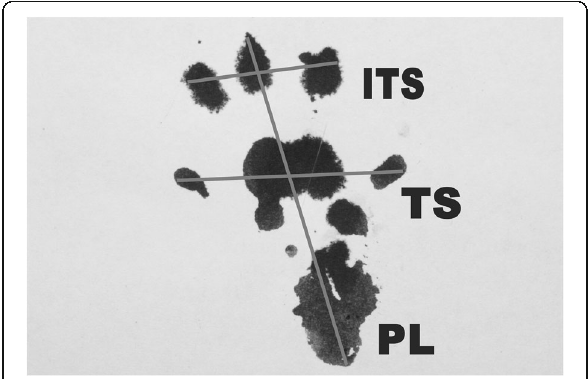
Fig. 2 Normal footprint after walking track analysis. (ITS intermediary toe spread, TS toe spread, PL print